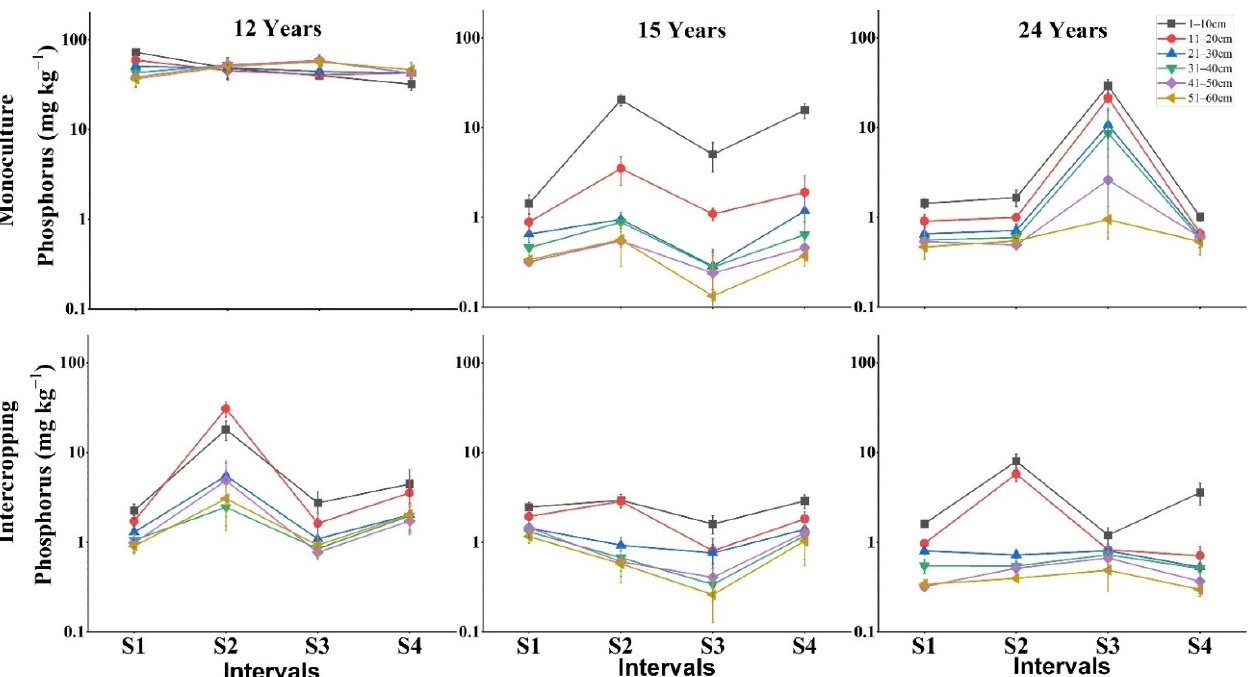
Figure 3. Soil available P in different soil layers across four sampling intervals (S1, June 2018; S2, September 2018; S3, December 2018; S4, March 2019) within different-aged stands of two plantation management types (rubber monoculture versus rubber–F. macrophylla intercropping).